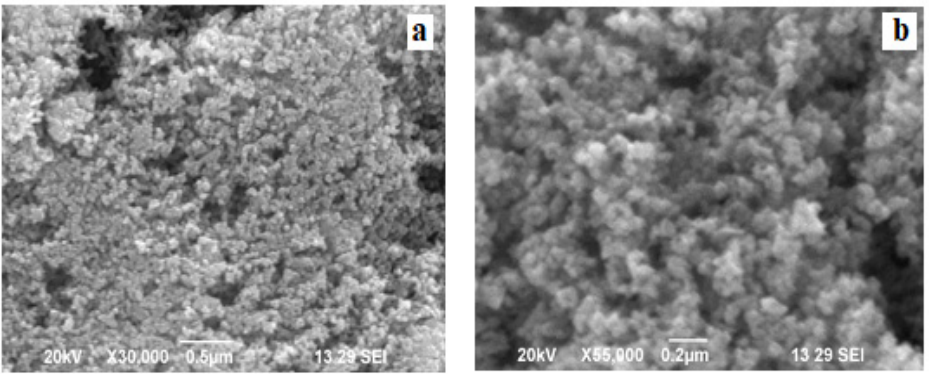
Figure 4. ( a , b ) SEM micrographs of ZnO nanoparticles with AML. Figure 4. ( a,b ) SEM micrographs of ZnO nanoparticles with AML.